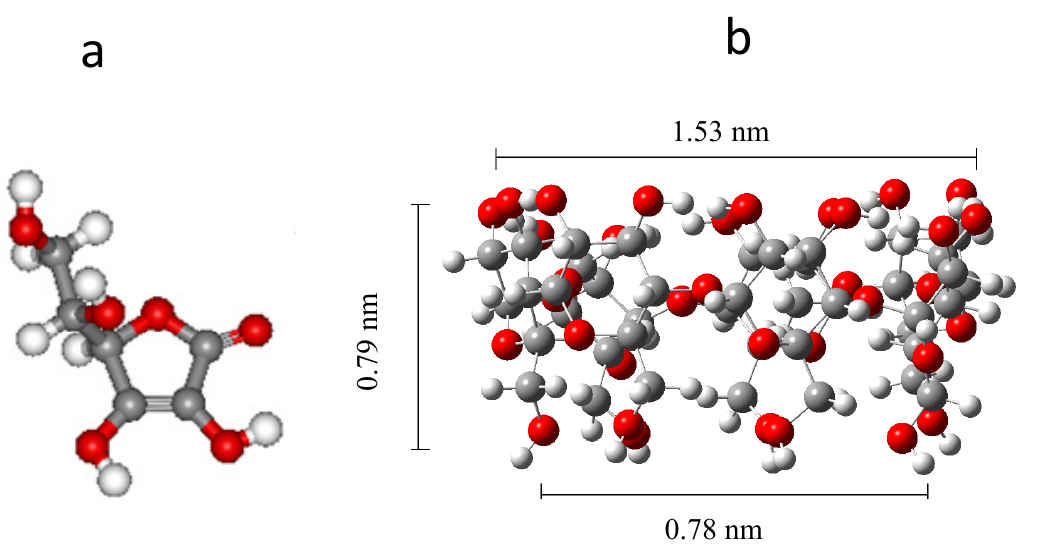
H O [27]. 42 70 35